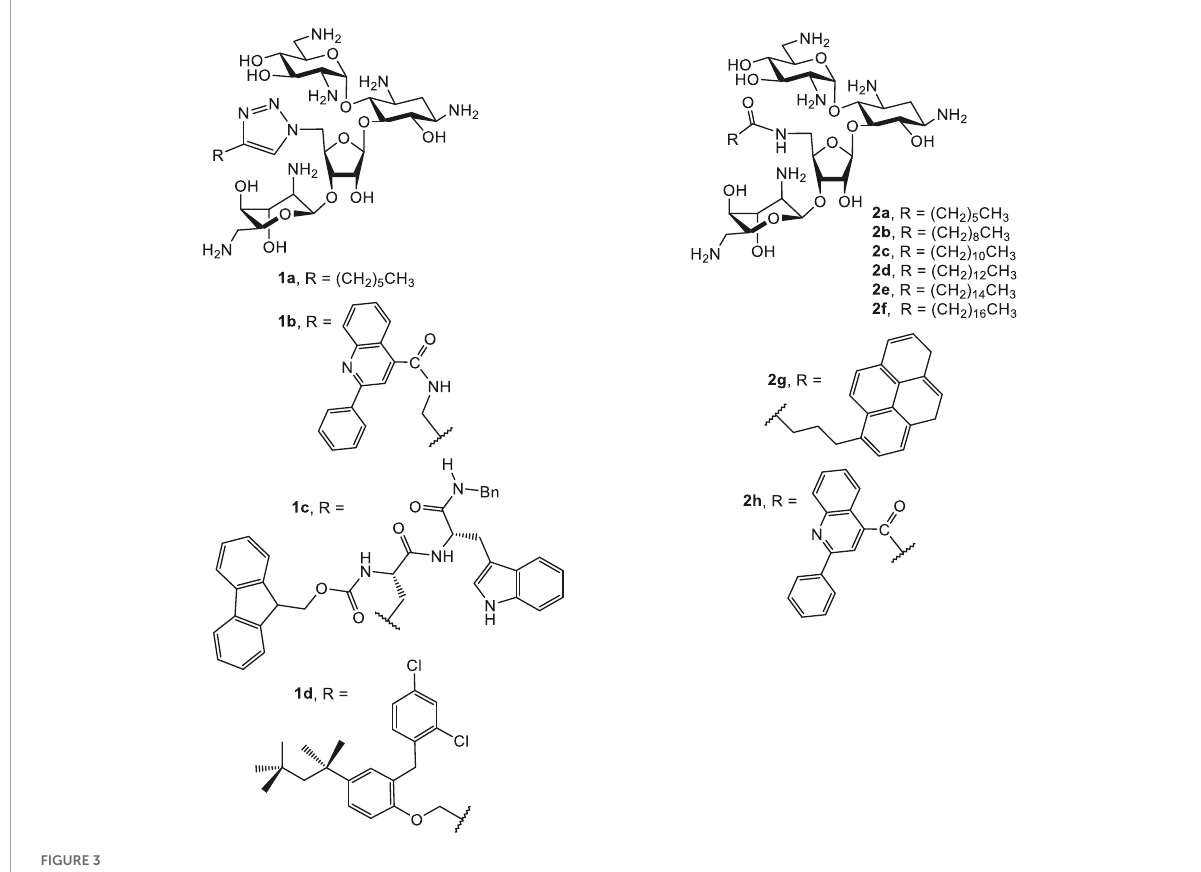
FIGURE3 Structures of representative amphiphilic